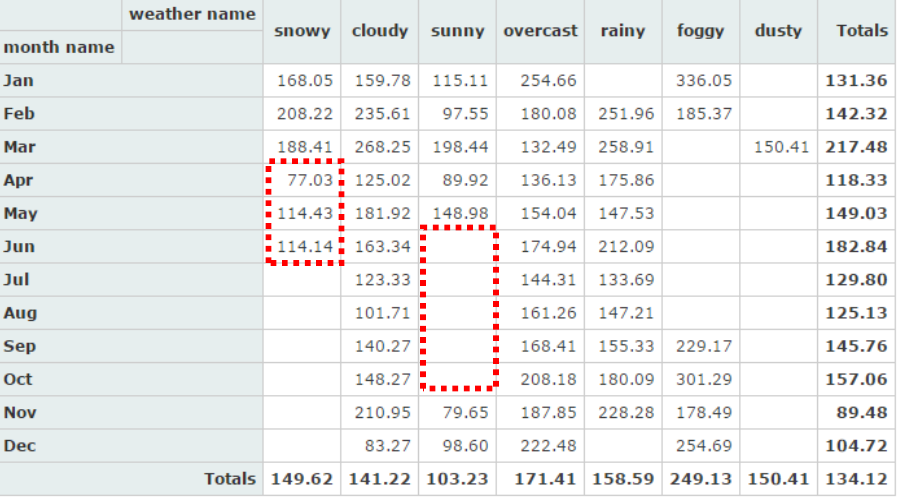
Figure A3. The average AQI of PM 2.5 as shown in PivotTable; rows represents months, and columns contain the weather data. With PivotTable.js, this table can be reproduced by making the row as